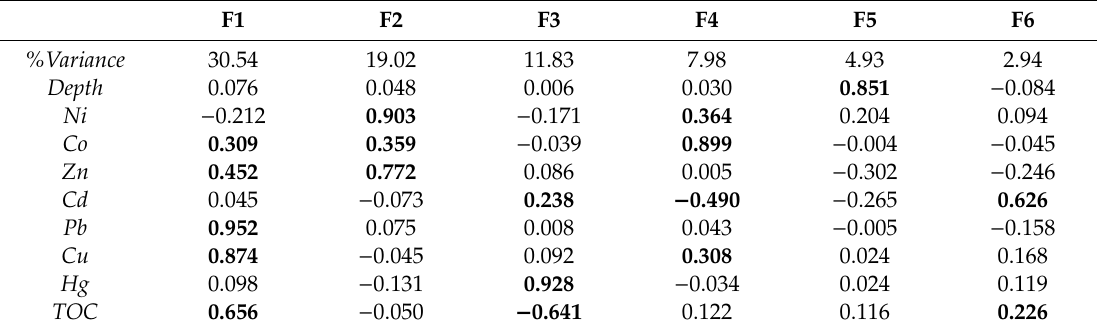
Table 4. Sorted (Varimax) rotated factor loadings of the original variables on the six principal factors for all depth (long monitoring) data set. The loadings > 0.3 are highlighted in the table. Empty cells in the table are related to loadings lower than